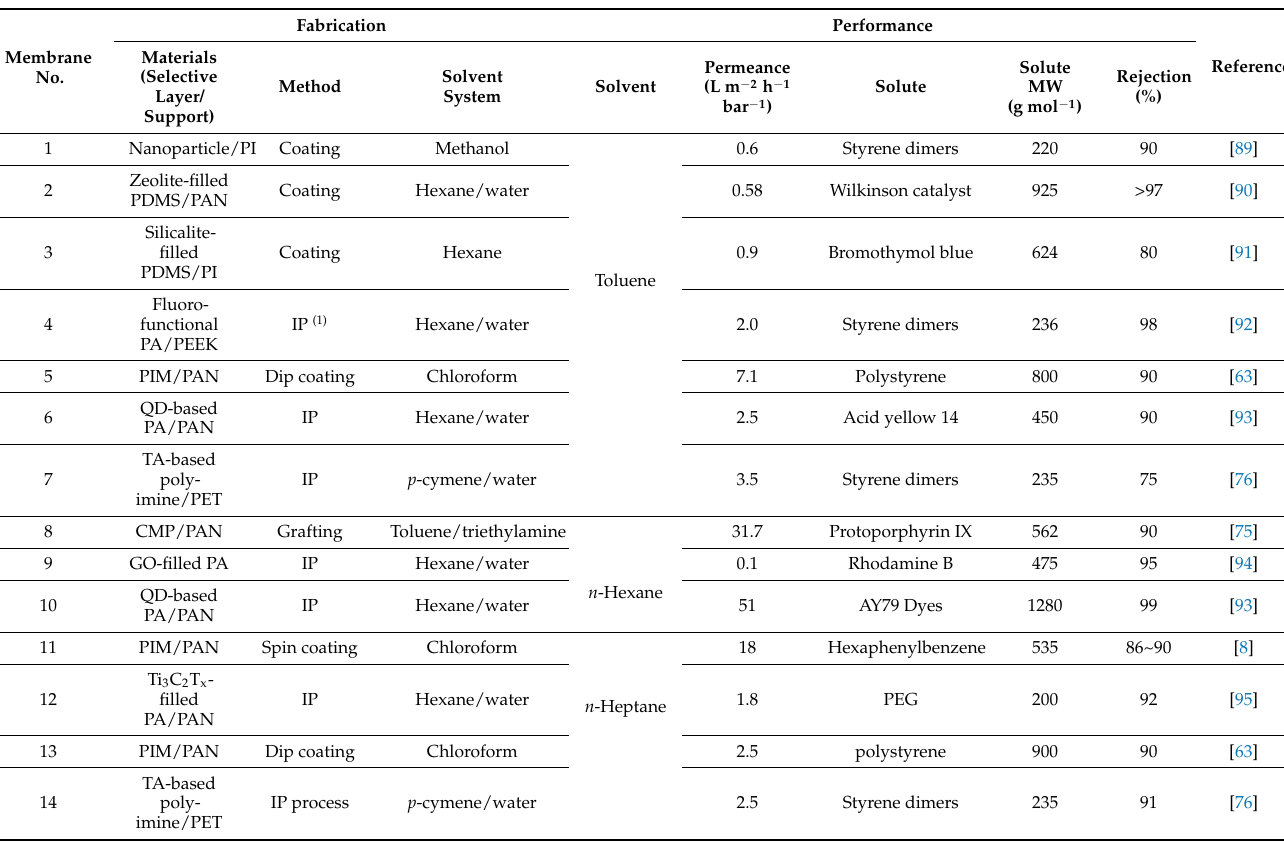
Table 2. Membrane materials and performance in non-polar solvents such as toluene, n -hexane, and n -heptane.